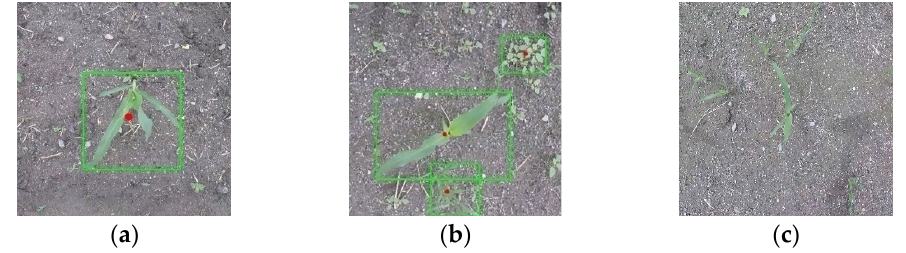
Figure 9. Samples of different identification results: ( a ) true positive (TP) sample; ( b ) false positive (FP)